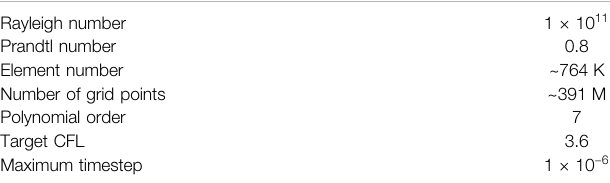
TABLE 1 | Summary of key simulation parameters. Rayleigh